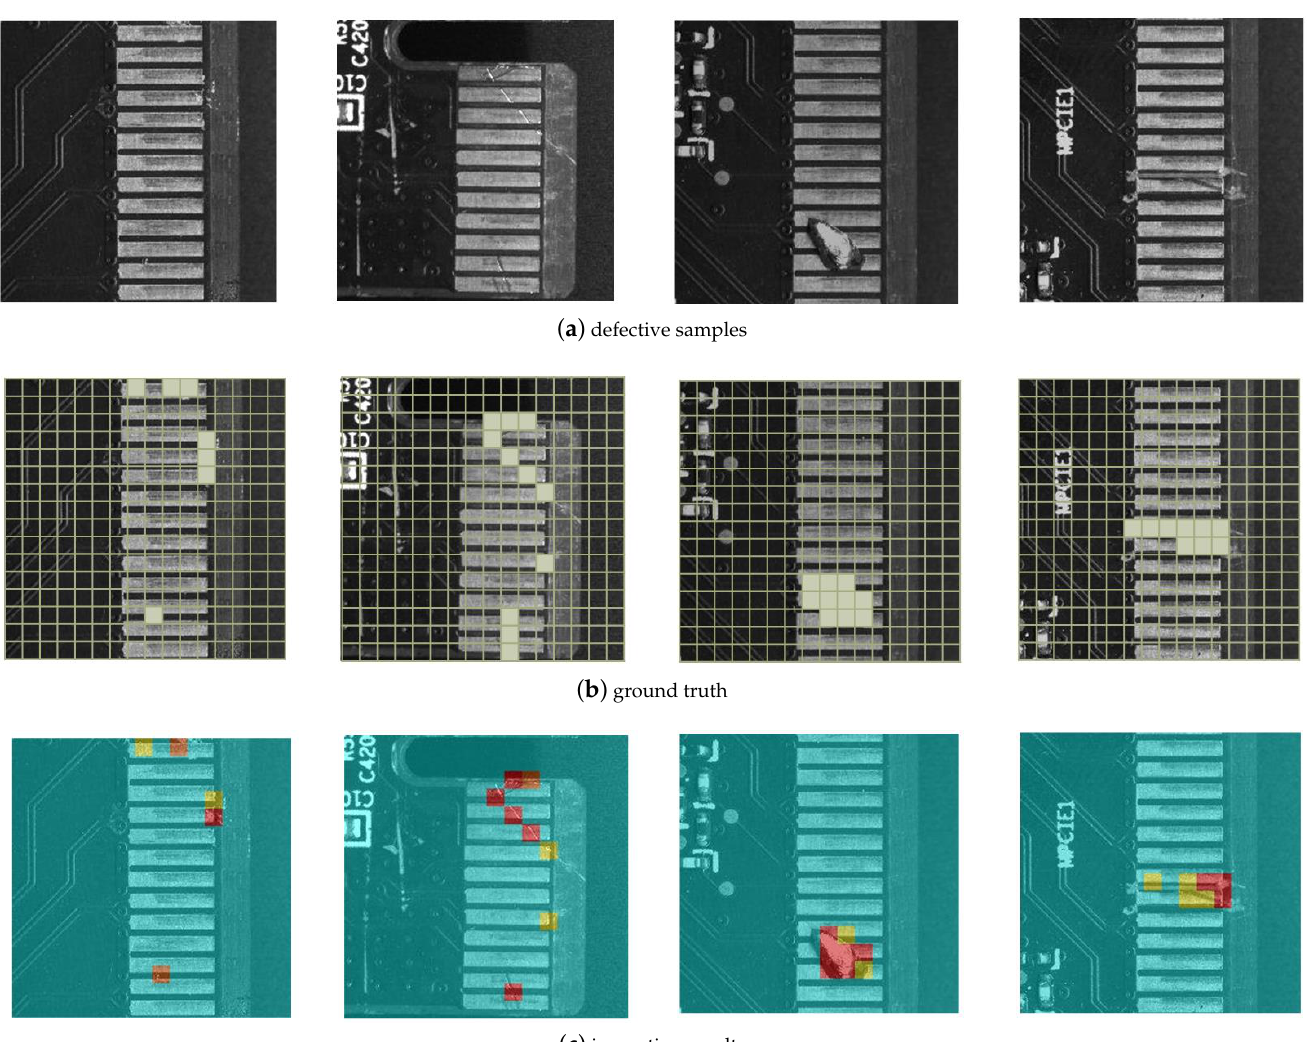
Figure 12. Examples of the defective samples, their ground truth, and inspection results for gold finger